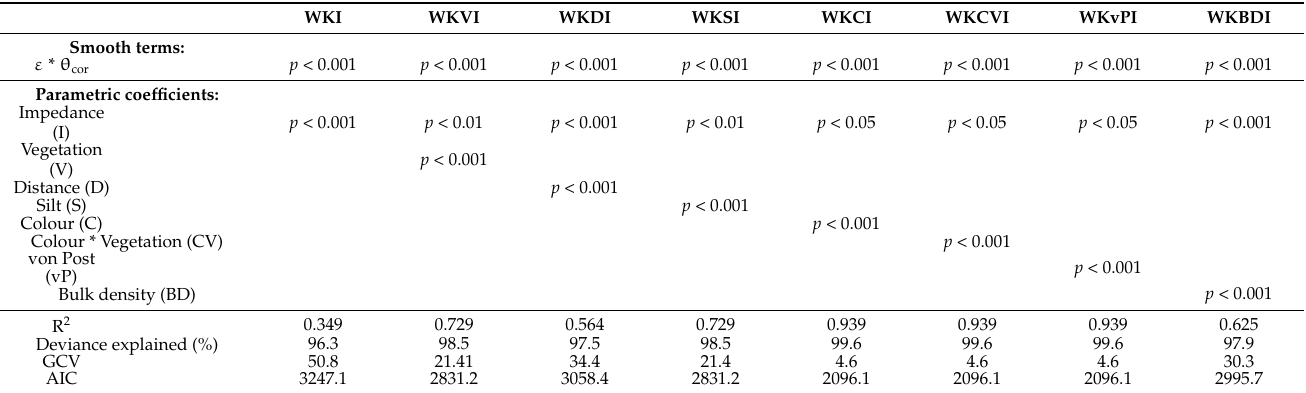
Table 4. Generalised additive models explored to predict the content of organic carbon at Vejrumbro based on in situ measurements of dielectric permittivity ( ε = K) and the corrected volumetric water content ( θ cor = W) as interacting smooth terms, measured impedance (Z = I), and different categorical (parametric) variables. Bold letters denote components in model names. Full model performances are provided in the Supplementary Material (Figures